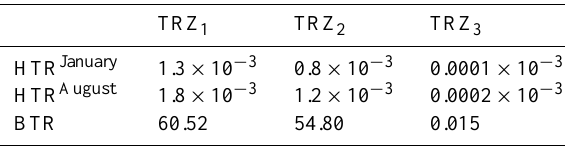
Table 7. HD in January and August and BD (in millions of Euros) in the TRZ i ( i = 1 , 2 , 3).